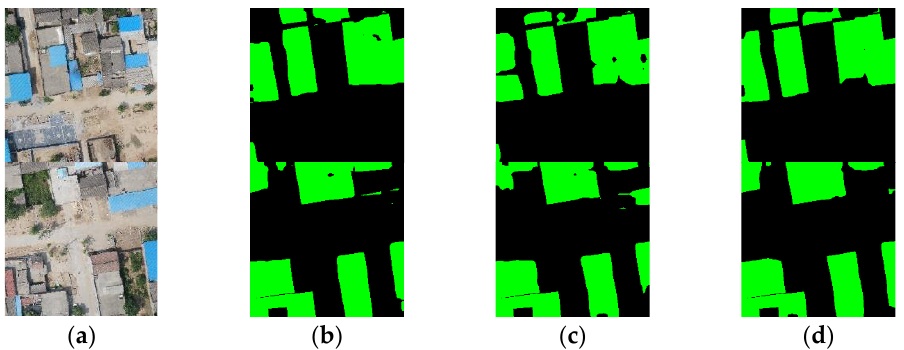
Figure 15. Example of extracted results from ablation experiment with the Weinan building dataset. ( a ) The input images, ( b ) results extracted with the proposed EDSANet model, ( c ) EDSANet without DAM, and ( d ) EDSANet without AFRM.